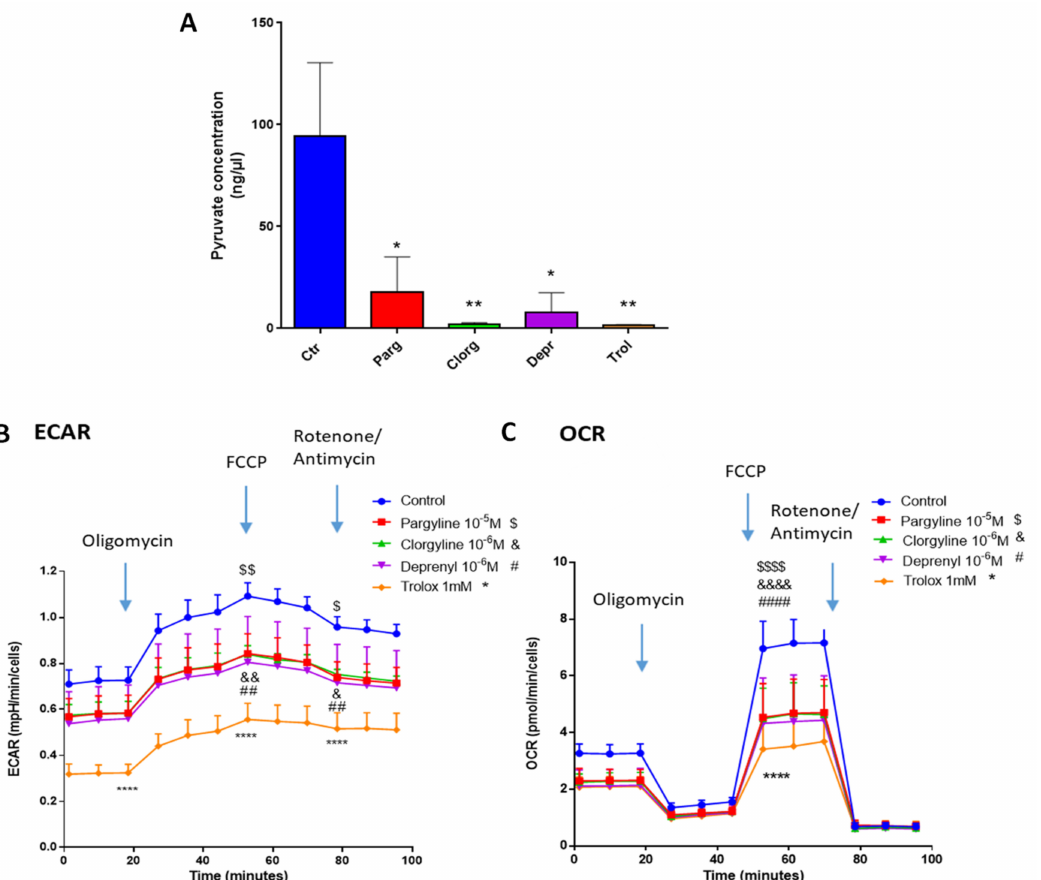
Figure 8. MAOs regulate glycolysis in vitro. ( A ) Pyruvate Assay Kit was used to determine the concentrations of pyruvate in AY27 cells treated with different inhibitors for 96 h (pargyline 10 − 5 M, clorgyline 10 − 6 M, deprenyl 10 − 6 M) and Trolox 1 mM (N = 3). ( B , C ) Extracellular acidification rate (ECAR) and oxygen consumption rate (OCR) of AY27 cells cultured with different inhibitors (pargyline 10 − 5 M, clorgyline 10 − 6 M, deprenyl 10 − 6 M) or Trolox were measured with Seahorse XFe24 (N = 3). All the values are presented as mean ± SEM. * p < 0.05, ** p < 0.01, **** p < 0.0001, & p < 0.05, && p < 0.01, &&&& p < 0.0001, ## p < 0.001, #### p < 0.0001, $ p < 0.05, $$ p < 0.01, $$$$ p < 0.0001 vs.